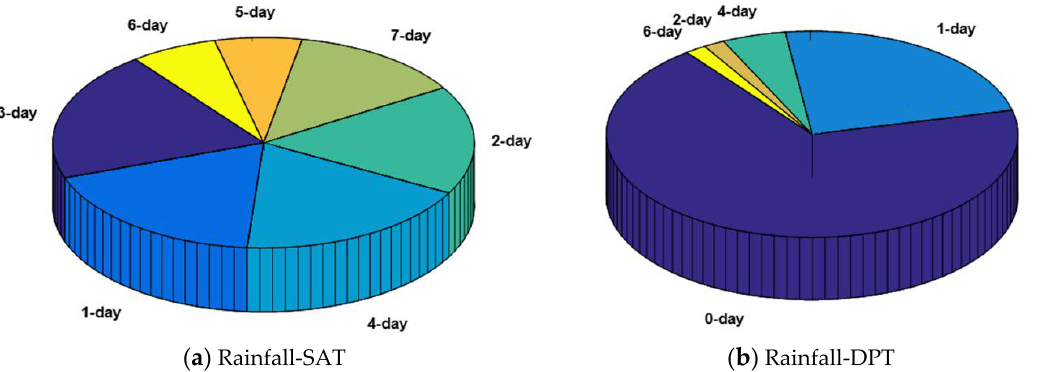
Figure 4. Distribution of preceding-day showing maximum sensitivity in 95% daily rainfall depth.